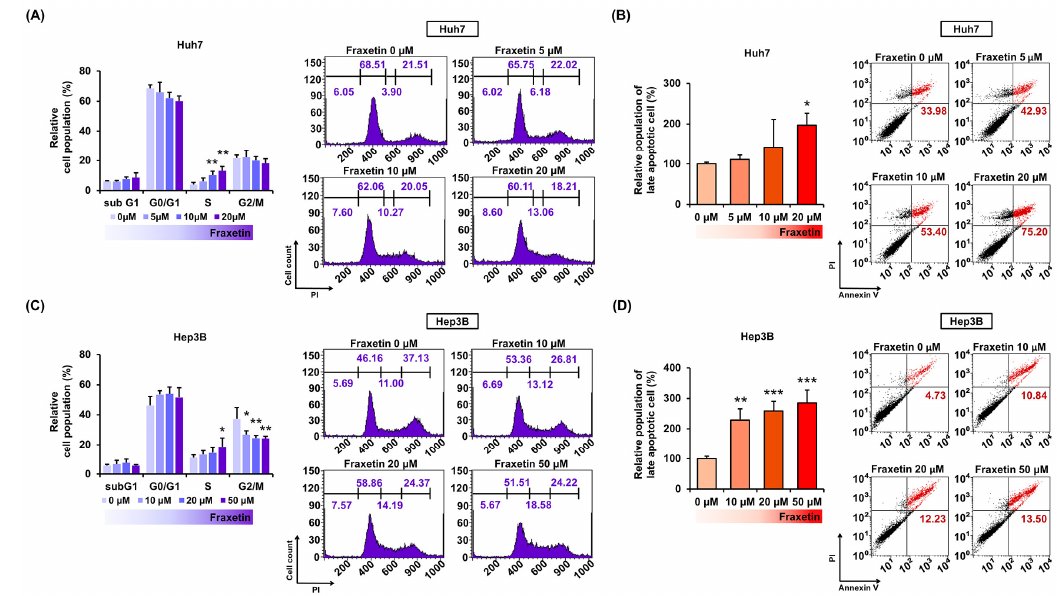
Figure 2. Effects of fraxetin on cell cycle arrest and apoptosis in Huh7 and Hep3B cells. ( A , B ) Cell cycle arrest in Huh7 and Hep3B cells was confirmed using propidium iodide (PI) staining and flow cytometry (FACS). ( C , D ) The hepatocellular carcinoma cells were stained with annexin V and PI to detect late apoptotic cells via FACS. The late apoptotic cell population are located in the upper right quadrant and the bar graph represents the percentage ratio values. Asterisks indicate the significance levels of comparisons between vehicle- and fraxetin-treated cells (* p < 0.05, ** p < 0.01, and *** p < 0.001).